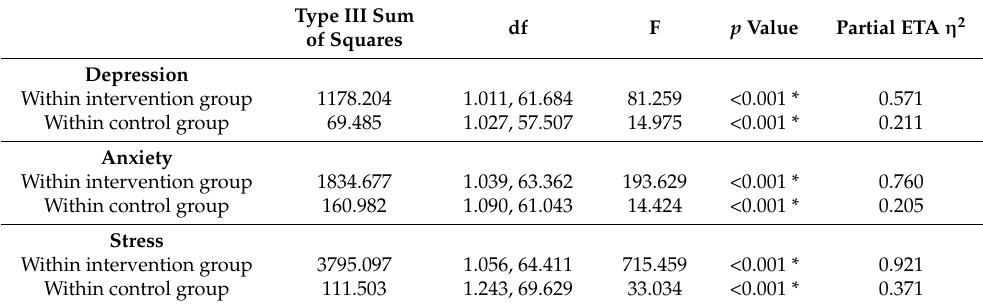
Table 4. Post-intervention comparisons of depression, anxiety, and stress scores within each group.